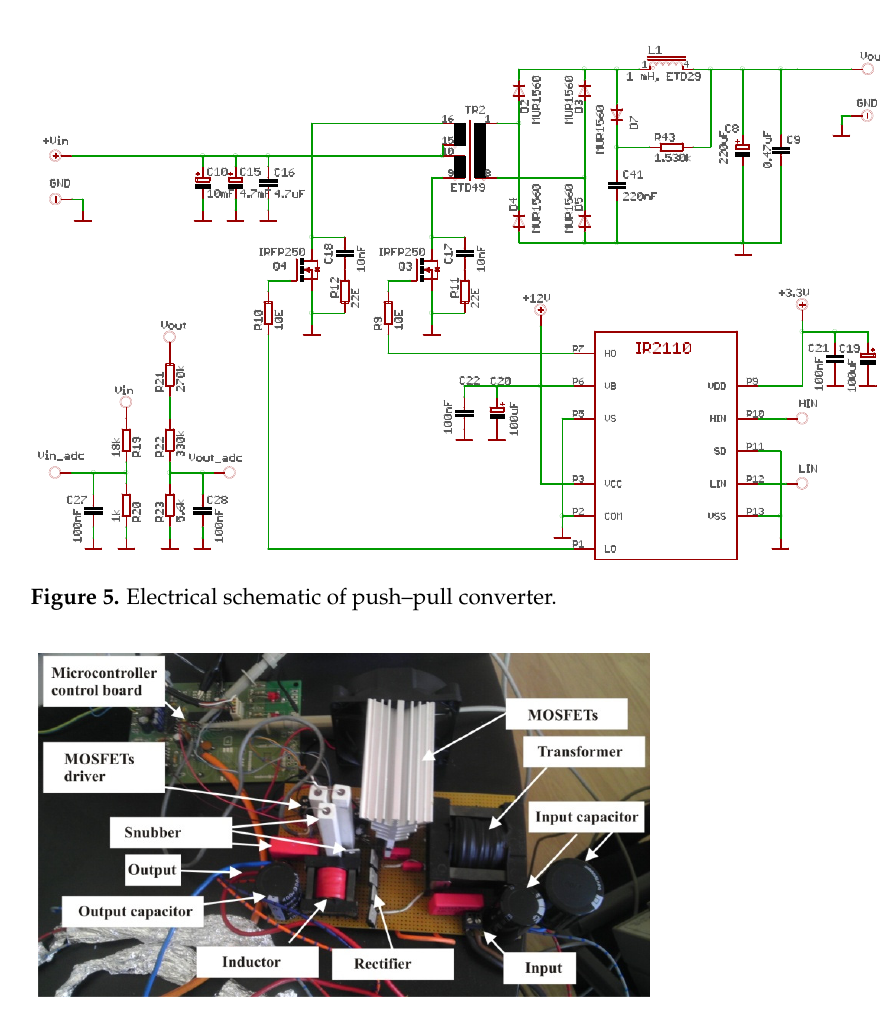
measurement error is 1%. Resistor, 75 Ω , and MOSFET were used to simulate the variable